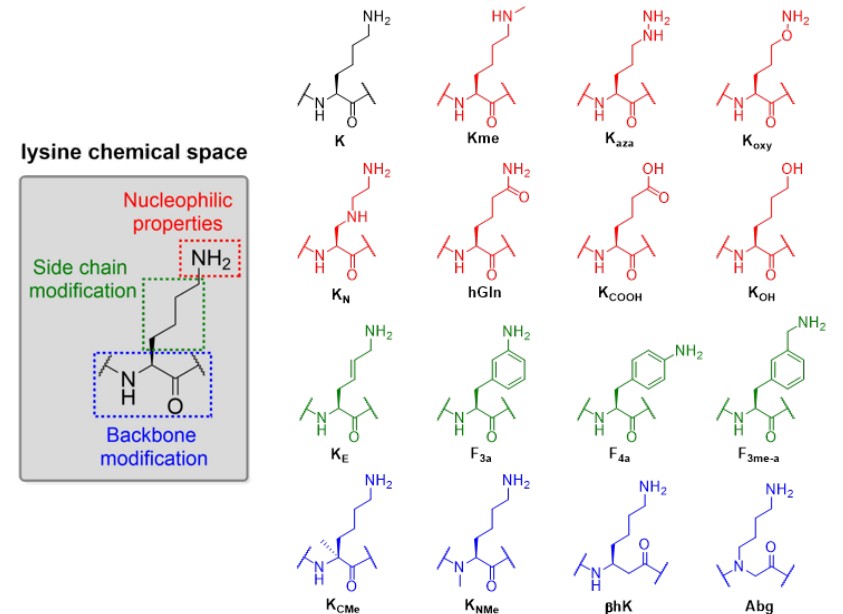
Figure 2. Exploring the substrate specificity for human KAT8 acetyltransferase, rationale and the panel of selected lysine analogues.